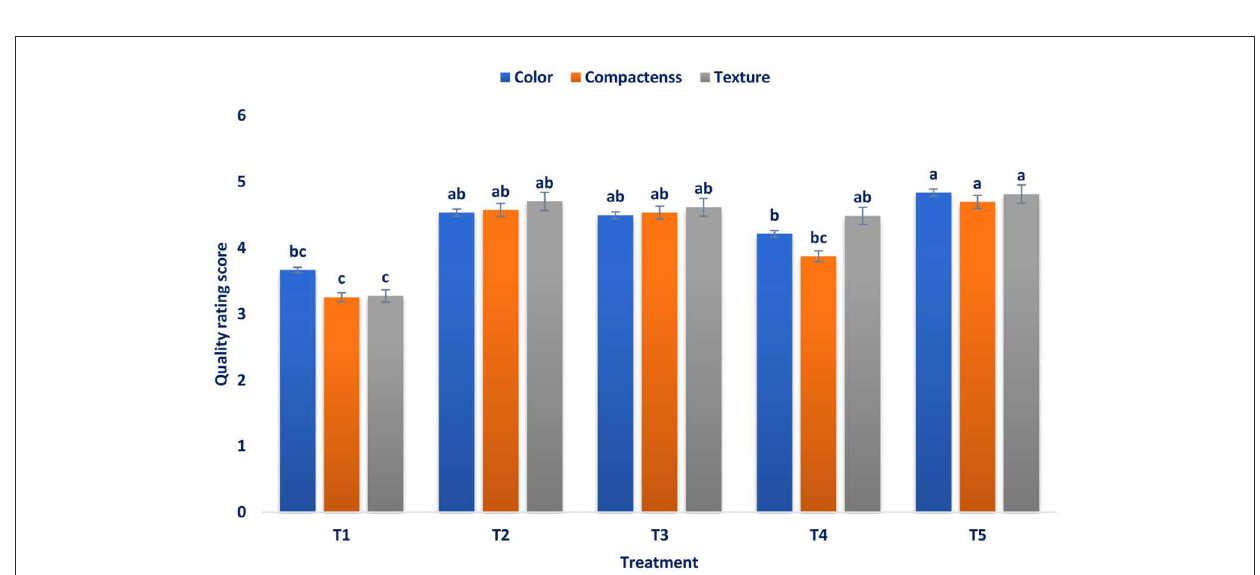
FIGURE4 Influence of pre-harvest foliar application of mineral nutrients on quality indices of fresh broccoli. T 1 = control, T 1 = control, T 2 = B, T 3 = Zn, T 4 = Mo, and T 5 = B + Zn + Mo, 0.40%,